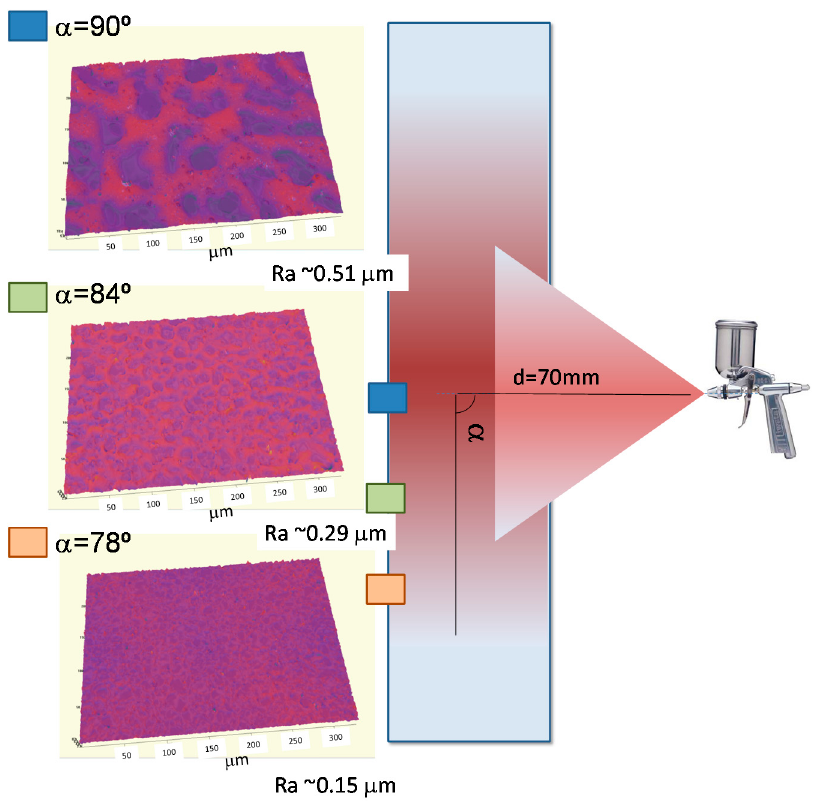
Figure 6. Schematic of spray apparatus employed to spray PS and blends of block copolymers and PS. The samples were sprayed at a distance d = 7 cm and pressure P = 28 Psi, under a constant temperature, to create five layers. The color images correspond to the 3D images of the samples at different positions from the center to the edge of the sprayed area.